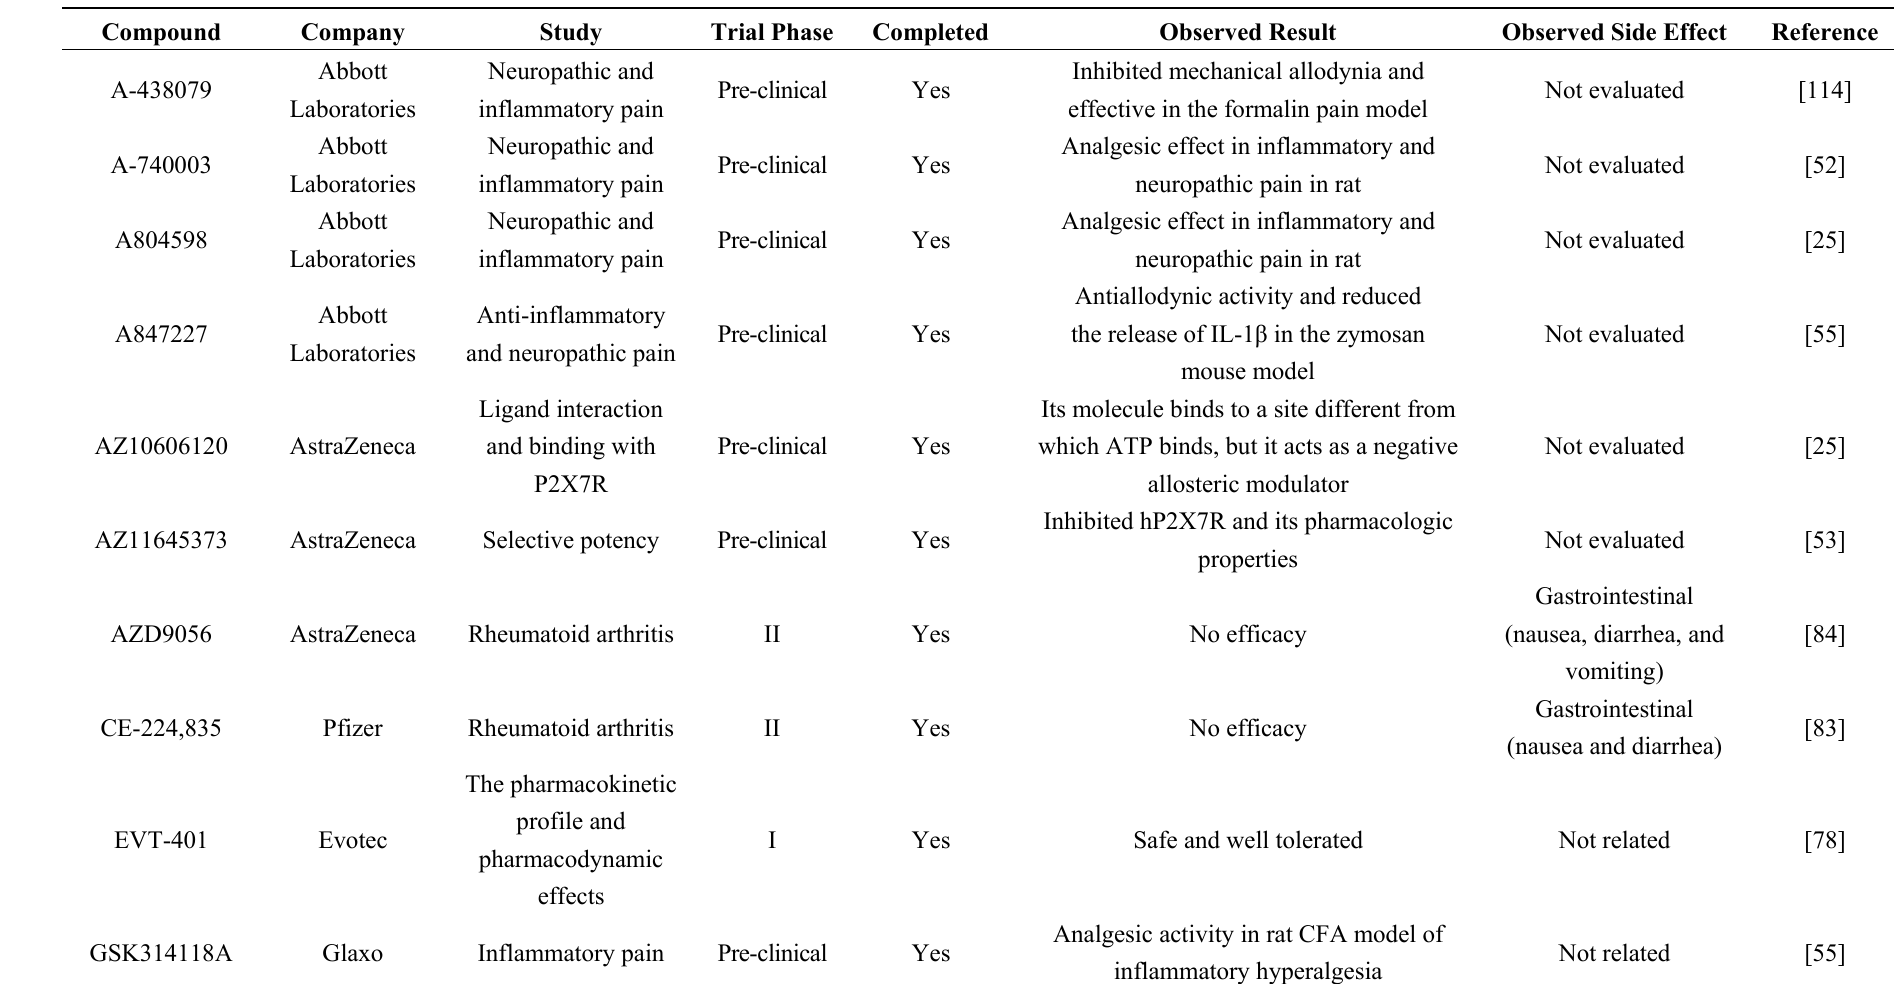
Table 2. Recently evaluated compounds with promising antagonistic activity against